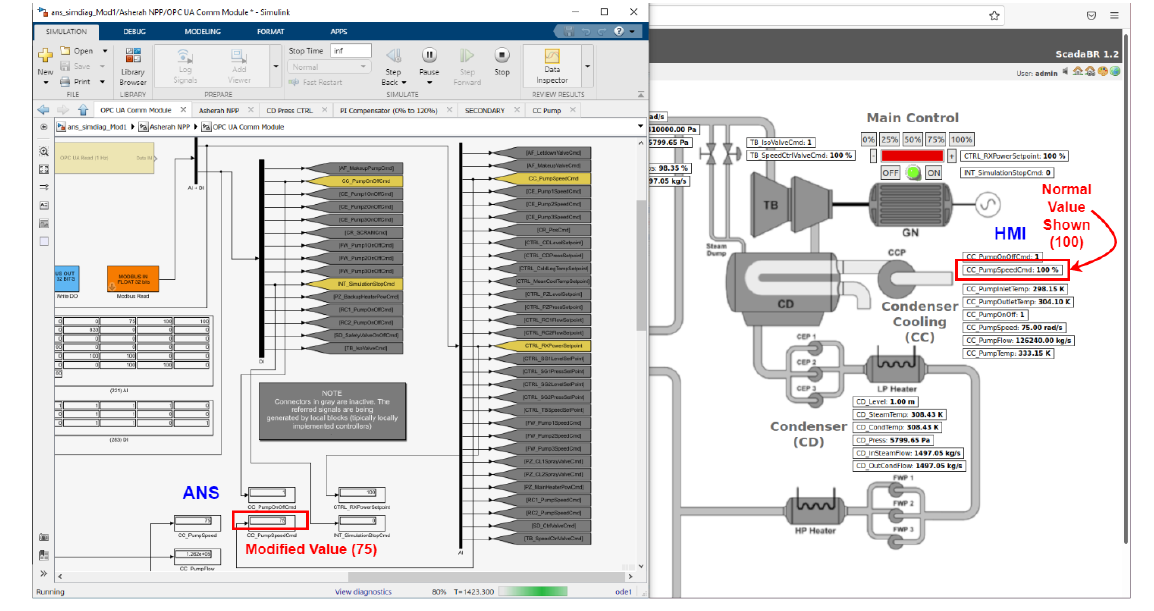
Figure 21. ANS and HMI under attack.